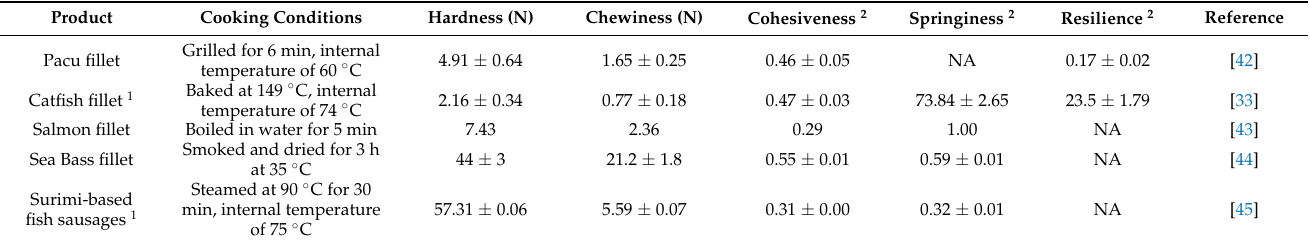
Table 2. Texture profile analysis (TPA) of various fish